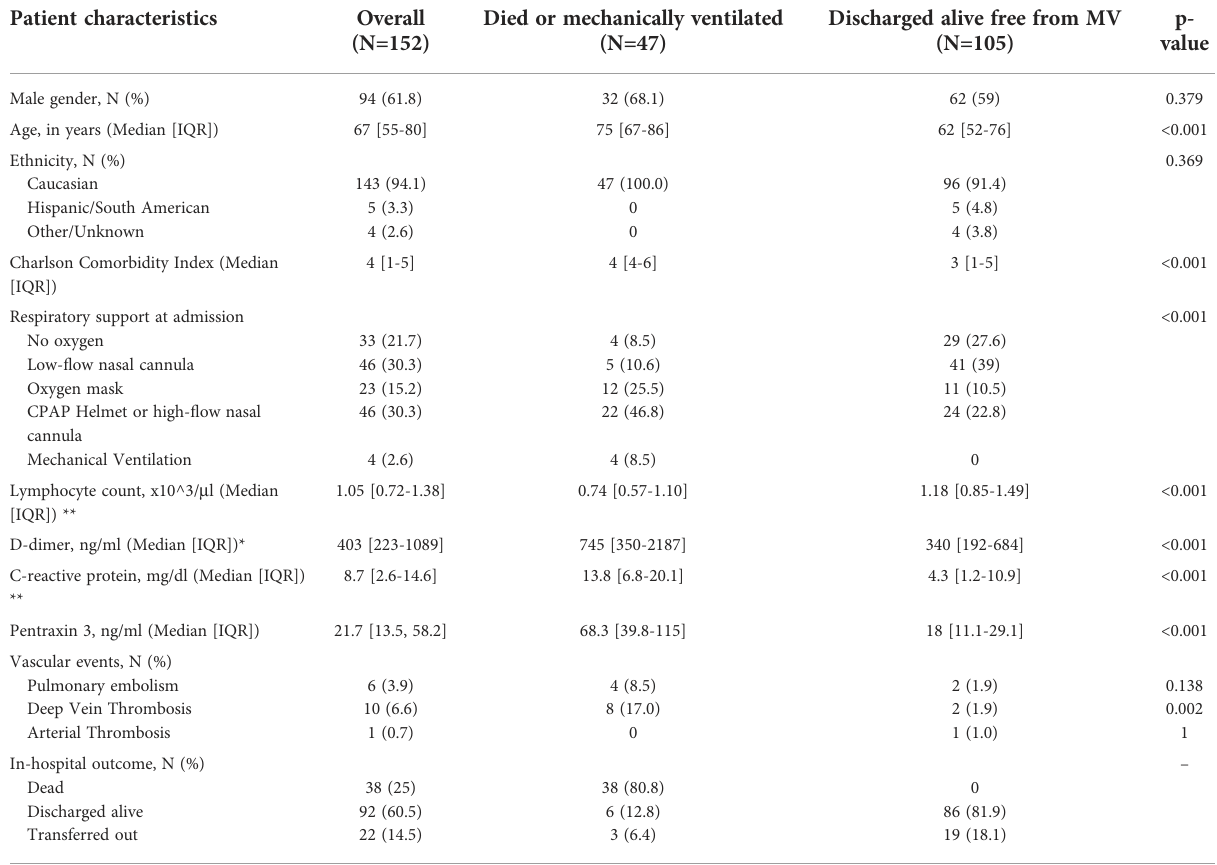
TABLE 1 Characteristics and outcomes of the patients included in the